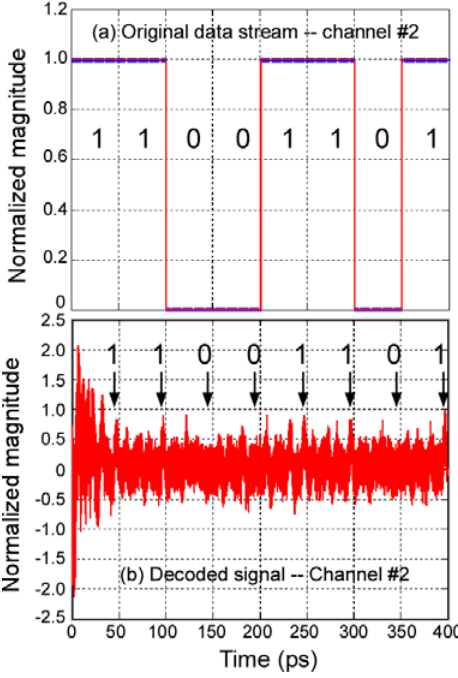
Figure 8. ( a ) the original #2 symbols (reshown from Figure 5(a) for better illustration); ( b ) decoded signal using with the code of [0 π 0 0 π 0 0 0 0 π ] for channel #2. The original channel #2 data stream 1 1 0 0 1 1 0 1 can be recovered using the